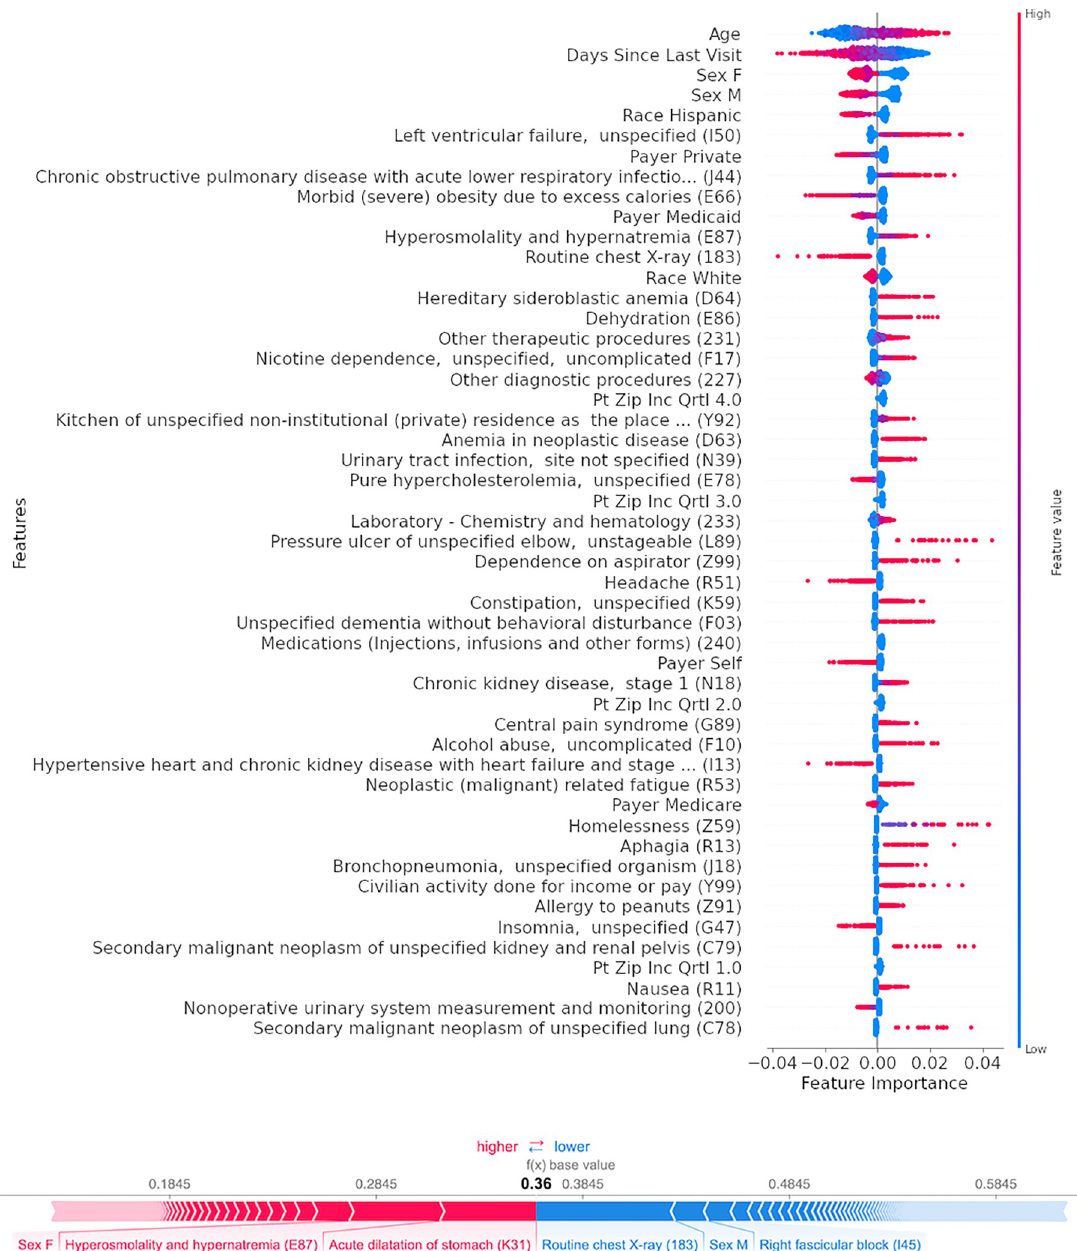
Fig 2. Overall and patient-specific features predictive of malnutrition. Upper panel shows the top 50 features predictive of malnutrition from the best performing model (LSTM with one-hot encoded trajectories) in descending order of influence (mean Shapley values over five visits for 1000 patients in California). Bottom panel shows risk factors for an individual malnourished